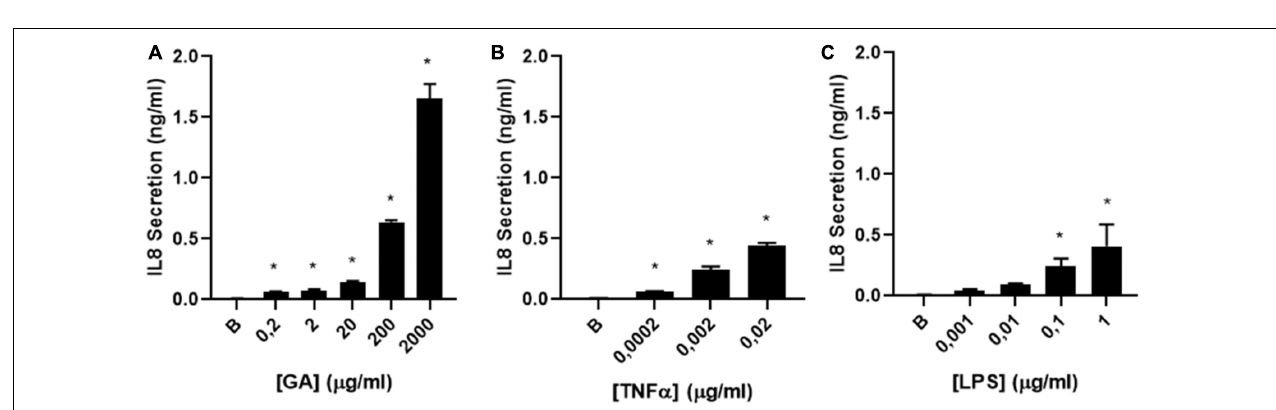
FIGURE 3 | IL-8 secretion by glycated albumin (GA) compared to TNF α and LPS. (A) dose–response curve of IL-8 secretion was determined in CF1-16 cells induced by (A) GA ( n = 3), (B) TNF α ( n = 3), and (C) LPS ( n = 3). All induced a dose-dependent IL-8 secretion, with a maximum effect on Il-8 production for TNF and LPS of 477.6 and 424 ng/mL, respectively, but GA was 4–5 times more effective, reaching a max effect of 2.0 ng/mL. The EC 50 for LPS was 0.071 and 0.00193 µ g/mL for TNF compared to 424 µ g/mL for GA. * indicates a significant increase ( p < 0.05) in IL-8 secretion compared to the background (B)